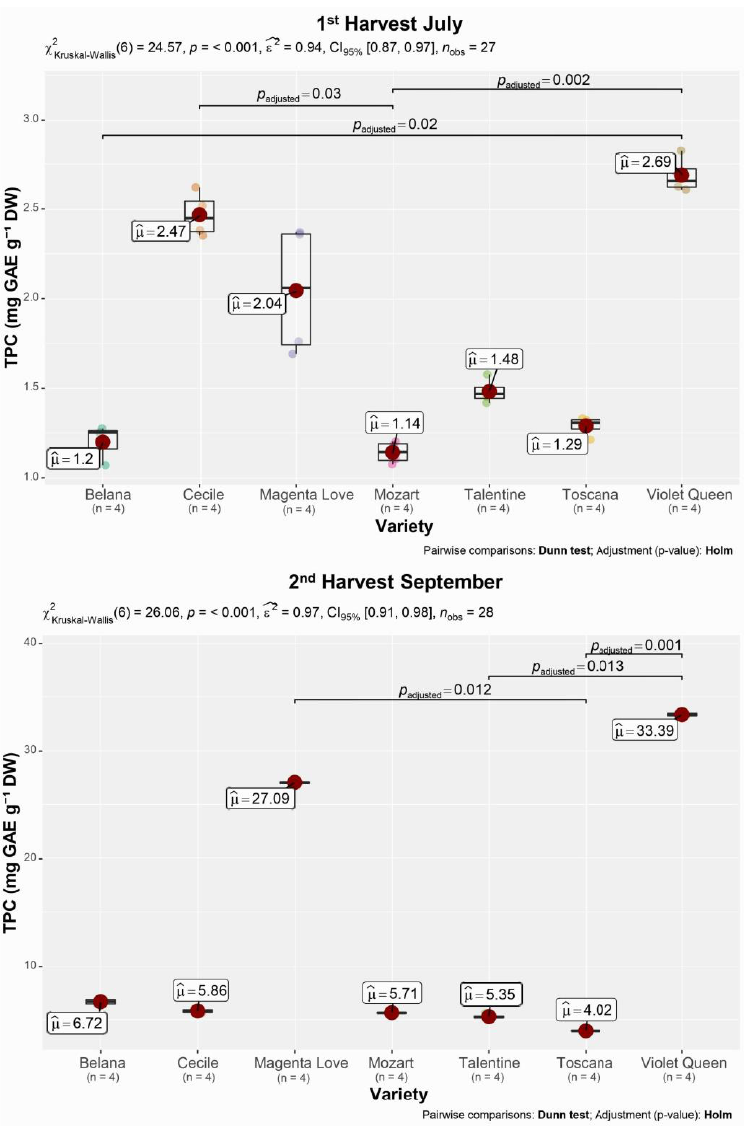
Figure 3. Statistical differences in total polyphenol content (TPC) between individual potato varieties harvested in July (1st harvest) and September (2nd harvest).